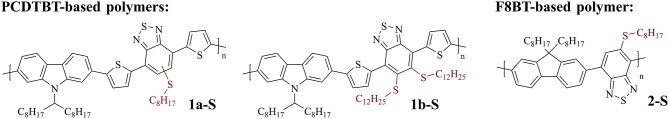
Conjugated polymers used to investigate the post-polymerization modification with DMDO. Left: PCDTBT-based polymers with one (1a-S) and two (1b-S) thioalkyl substituents attached to the benzothiadiazole units. Right: F8BT-based polymer with one thioalkyl substituent attached to the benzothiadiazole units (2-S).